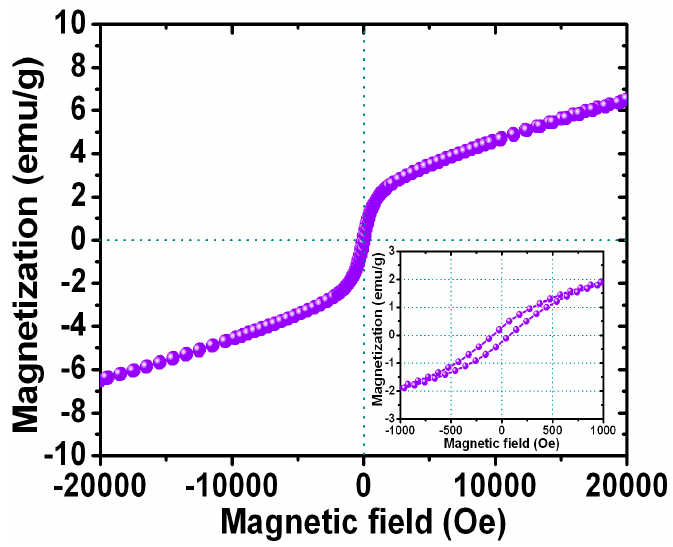
Figure 7. Magnetization loop for the FePt NPs after ligand exchange with thiol. The inset shows the corresponding enlarged hysteresis loops for FePt-thiol NPs measured in the field of ±1000 Oe.